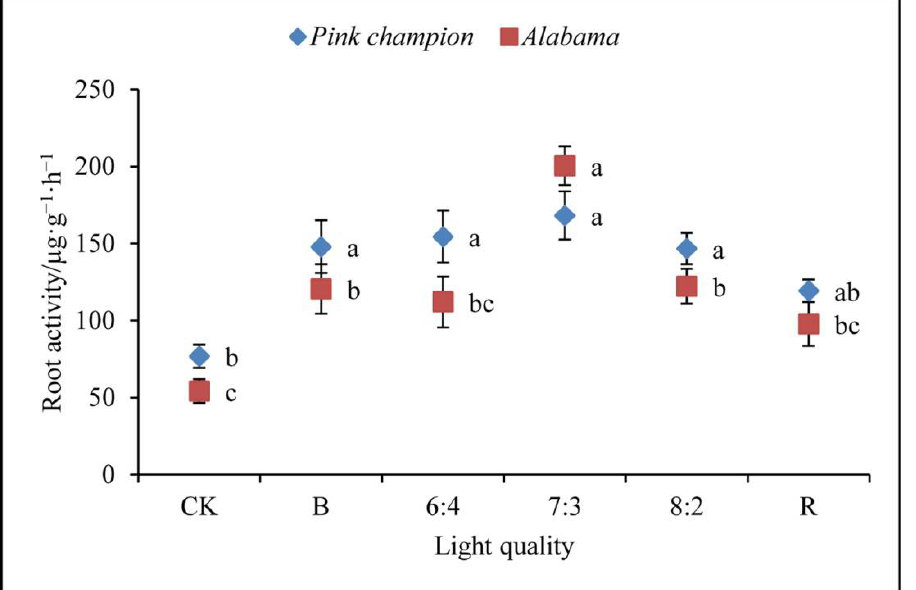
Figure 2. Effects of different light qualities on root activity of Anthurium ‘Pink Champion, Alabama’. The statistical analysis has been carried out separately for each cultivar. Vertical bars indicate standard error ( n = 5). Different letters represent significant difference at p < 0.05 among treatments by the Duncan’s multiple range test.